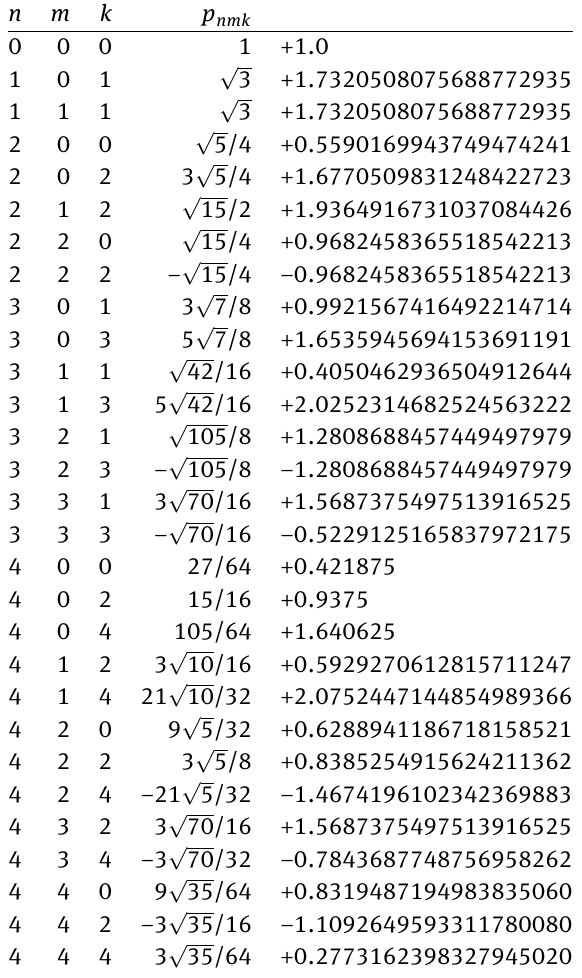
Table 1: Sample values of sine/cosine series coefficients of fnALF. Listed are the literal expression and 20 digits of all non-zero values of p nmk when 0 ≤ m ≤ n ≤ 4 and 0 ≤ k ≤ n . Notice that p nmk = 0 when (i) n − k is odd, (ii) n is even, m is odd, and k = 0 , (ii) n > m , and/or (iii) n > k